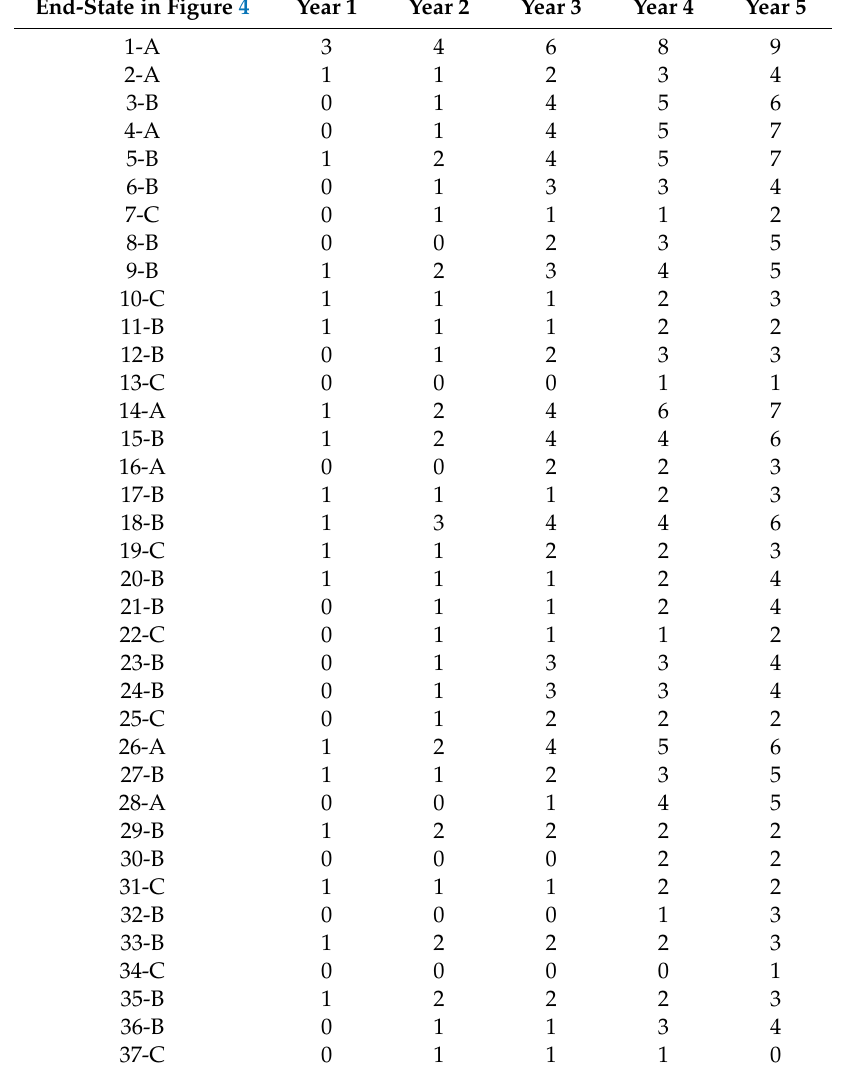
Table 6. Cumulative Accident Sequence Precursor (ASP) data for HP separator 1 for the last five years. End-State in Figure